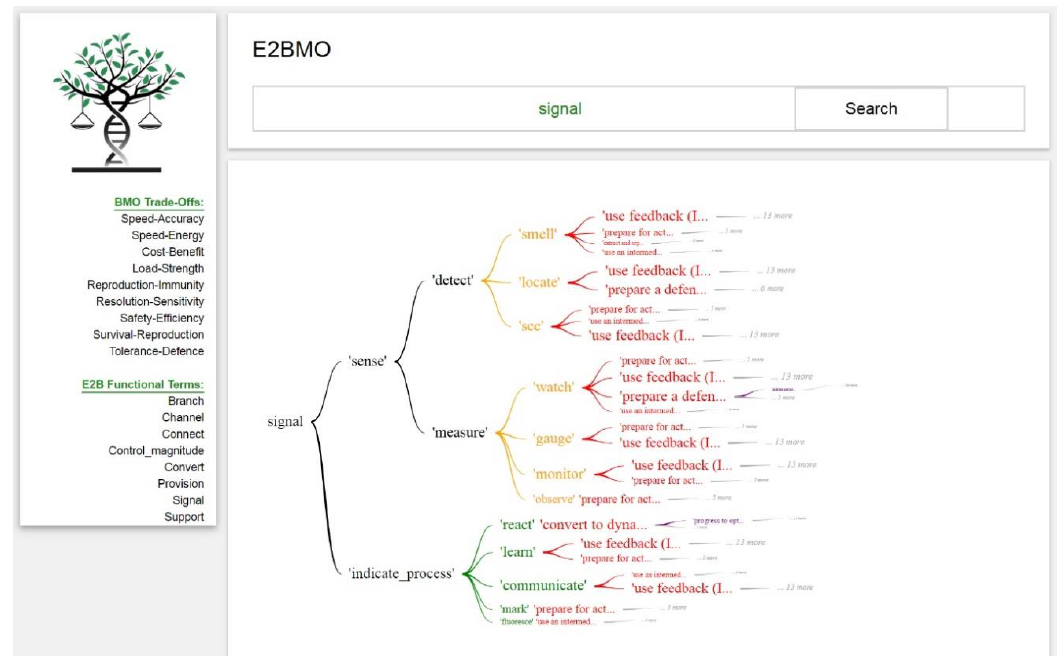
Figure 7. E2BMO query result for E2B functional word ‘signal’ to IPs in red.